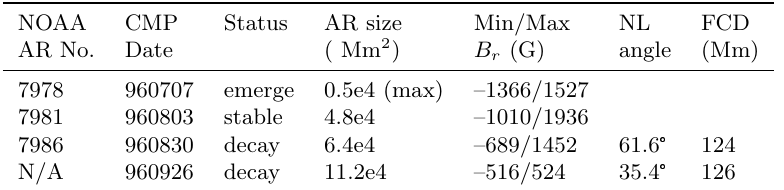
Table 5: Magnetic evolution for four rotations of NOAA 7978 based on measurements by Li and Welsch (2008) (extract from their Table 1. Abbreviations, which may require explanation: Central meridian passage (CMP), neutral line (NL), and flux centre distance (FCD), distance between the weighted positive and negative flux-centres. NOAA CMP Status AR size Min/Max NL FCD AR No. Date ( Mm 2 ) 𝐵 𝑟